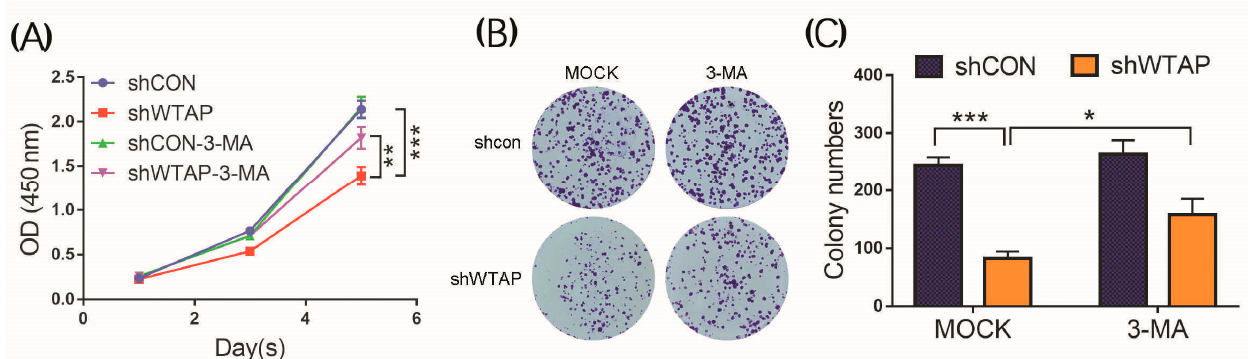
Figure 6. Effect of 3-MA on the proliferation of shWTAP-treated and shCON cells. ( A ) Determination of OD450 of shCON, shWTAP, shCON-3-MA, and shWTAP-3-MA cells at indicated times. ( B ) Colony formation analysis of shCON cells and shWTAP cells treated with 3-MA. ( C ) Statistical analysis of cell colonies between MOCK and 3-MA treatment groups. Error bars indicate the mean ± SD from three independent experiments ( n = 3). *** indicate a statistically significant difference ( p < 0.001). * indicate a statistically significant difference ( p < 0.05) and ** indicate a statistically significant difference ( p < 0.01).